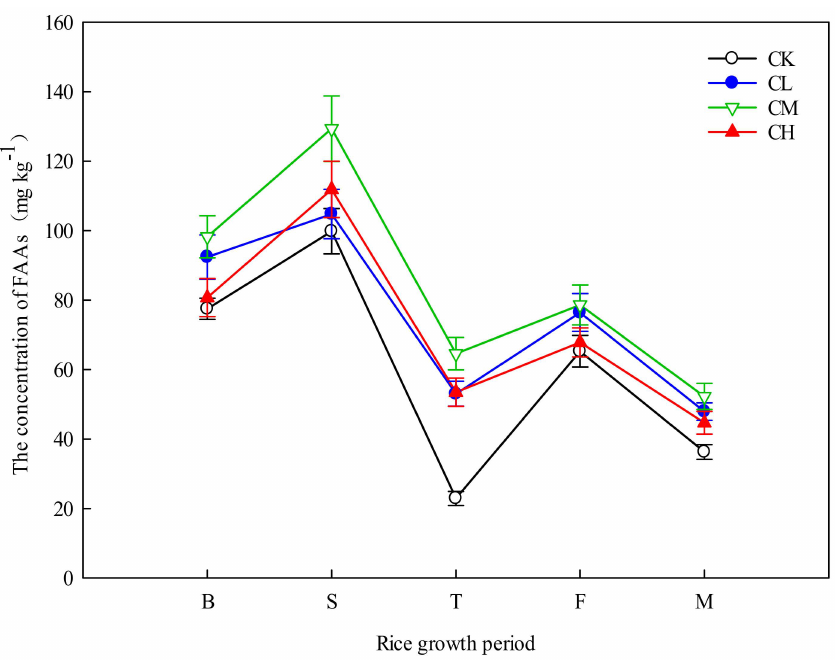
Figure 2. Dynamics of soil FAAs concentration under different fertilization treatments during different rice growth stages. Note: CK: chemical fertilizer, CL: the low amount of CMV, CM: the medium amount of CMV, CH: the high amount of CMV, B: background soil, S: seedling stage, T: tillering stage, F: flowering stage, M: maturity stage. The error line indicates a standard error (n =